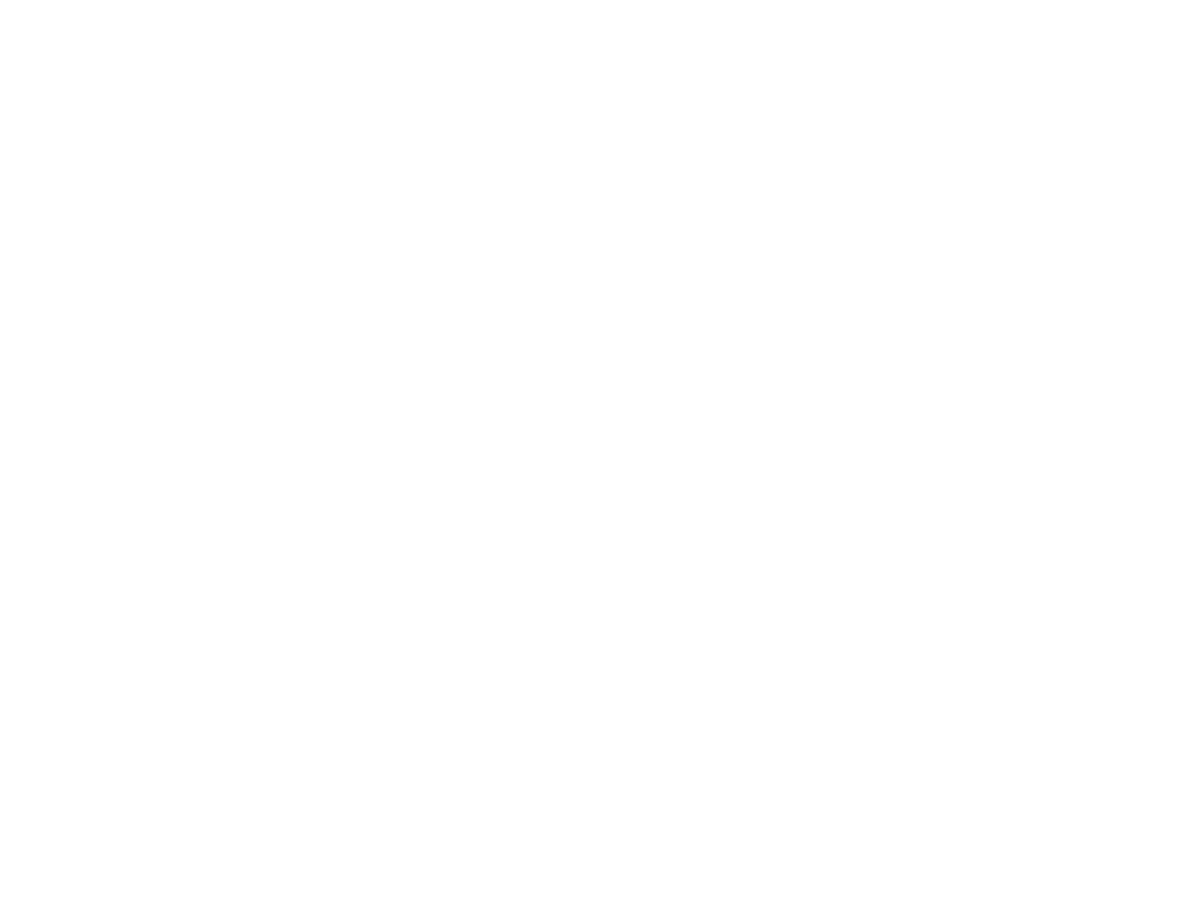
molecular weight complexes is marked with an asterisk. A molecular weight standard M was loaded, and the corresponding molecular weights are indicated on the left.The analyzed fragments were the following: csrB ( − 399 to + 5) (A) , csrC ( − 500 to + 4) (B) , uvrY ( − 507 to + 6 relative to translational start) (C) , and aspA ( − 422 to + 22 relative to translational start) (D)